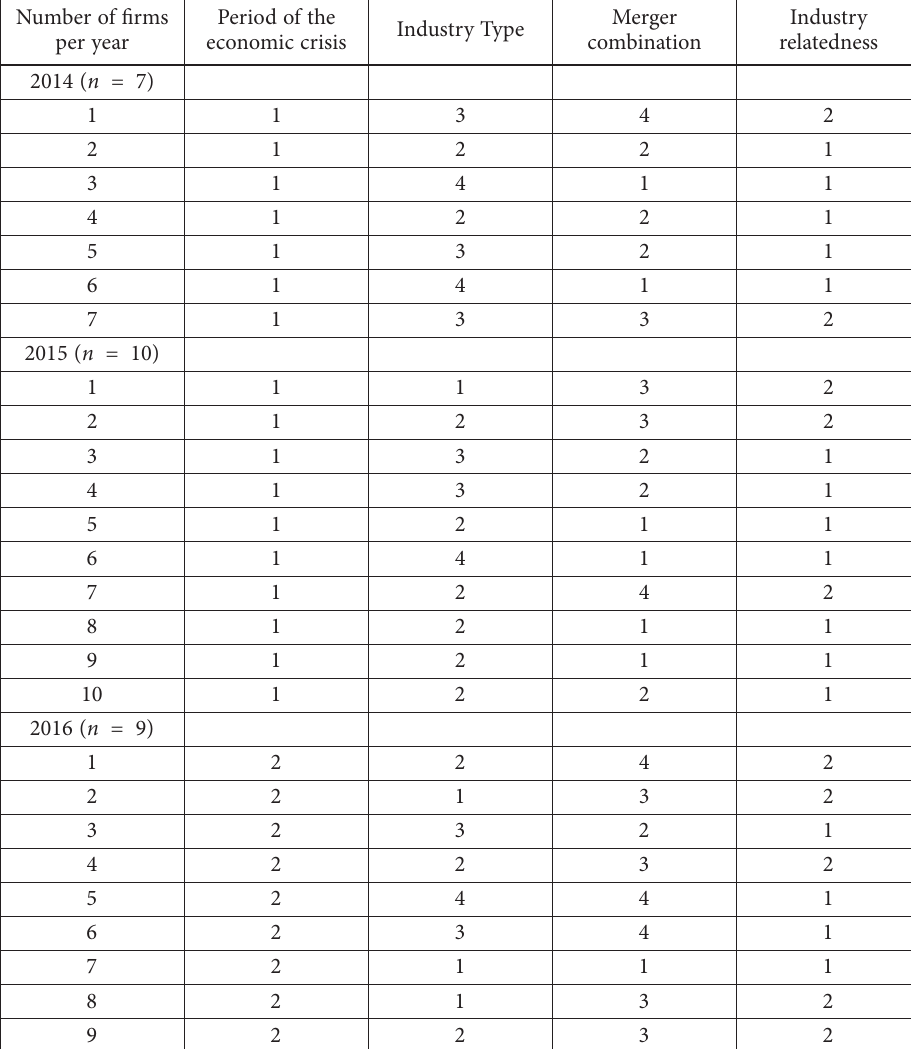
Table A1. Analytical presentation of qualitative variables broken down by merger characteristics Merger Industry Number of firms Period of the Industry Type combination relatedness per year economic crisis 2014 ( n = 7) 1 3